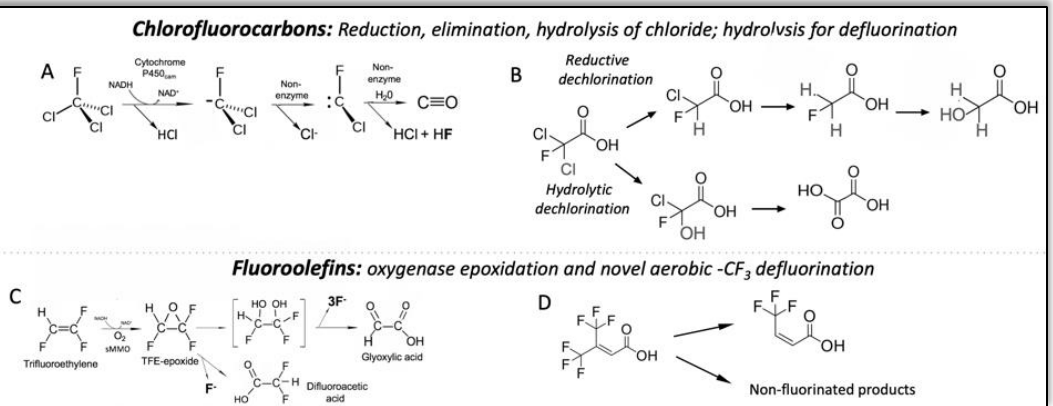
Figure 5. Metabolic activation in microbial defluorination. ( A ) Reductive dichlorination leading to ready defluorination catalyzed by the enzyme cytochrome P450 cam from Pseudomonas putida G7. ( B ) Reductive and hydrolytic declorination catalyzed by a microbial community leading to defluorina- tion. ( C ) Fluoroolefin epoxidation leading to defluorination catalyzed by soluble methane monoox- ygenase from Methylosinus trichosporium OB3b. ( D ) Unusual displacement of a trifluoromethyl group from a polyfluorinated olefin by a microbial community, mechanism unknown.